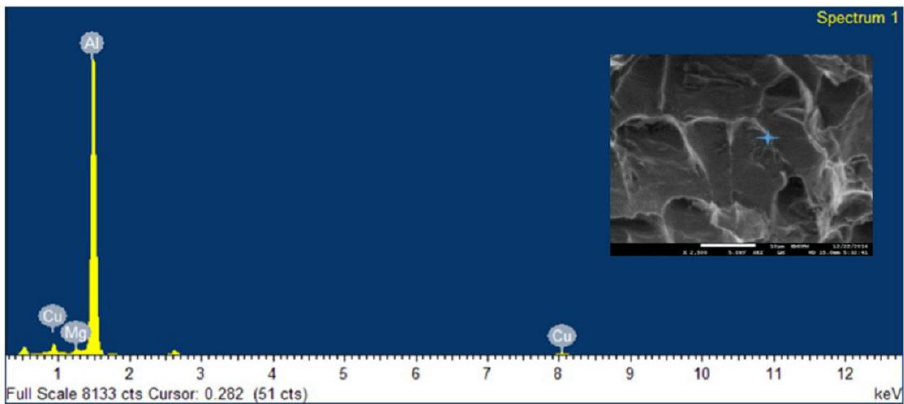
Figure 17. SEM image from RS-LHZ location: ( a ) 500×; and ( b ) 1000×. Because of the lower temperature in LHZ compared to NZ [28], and no mechanical work in LHZ, the existence of intermetallic Si/Al, Fe/Al and Cr/Cu/Al is acceptable (Figure 18).